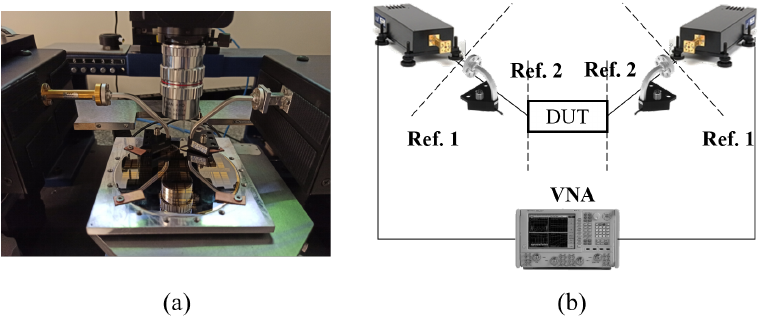
Figure 16. ( a ) Measurement set-up. ( b ) Two-tier de-embedding TRL procedure with reference planes.